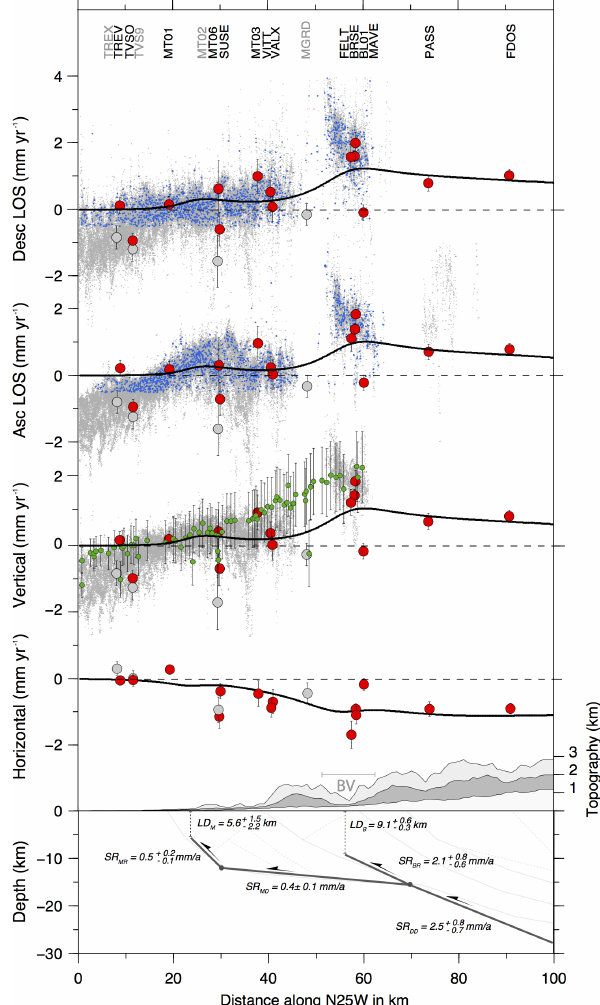
Figure 7. Cross sections across the A–B profile in Fig. 2 showing the modeled (black lines) horizontal and vertical velocities, as well as the SAR ascending and descending LOS rates, along with the measured ones. Gray-colored GPS sites have not been used in the inversion unlike the red ones. Green points indicate leveling data and small blue dots represent the subsampled InSAR LOS rates used during the inversion, which are displayed along with the un- subsampled InSAR dataset (light gray points). The bottom panel reports the optimal fault geometry with dip-slip rate and locking depth estimates and 95 percentile confidence bounds (see Sect. 5 for details). BV: Belluno